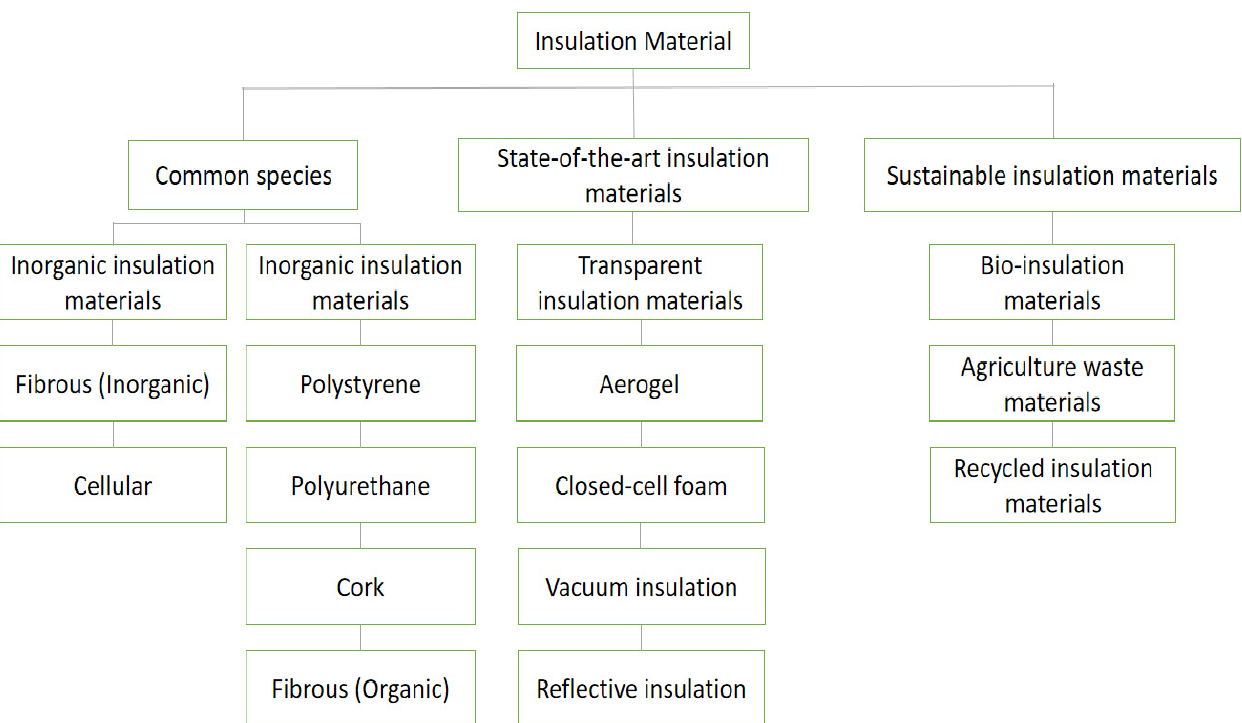
Figure 1. Classification of insulation materials for building applications.